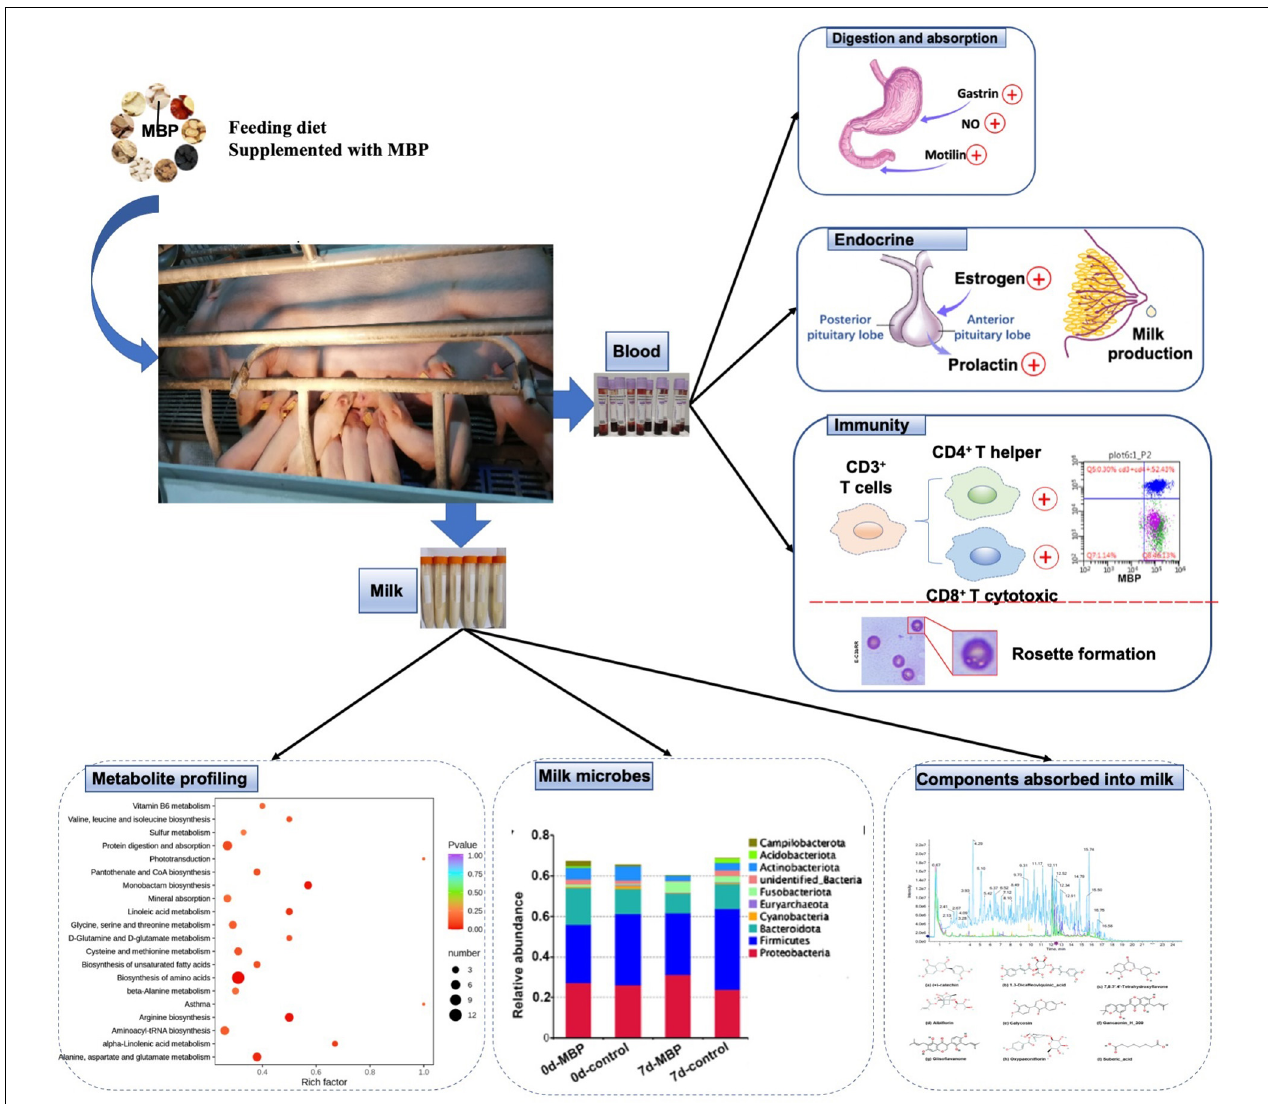
FIGURE 9 | Diagram of the mechanism of MBP’s effect on postpartum